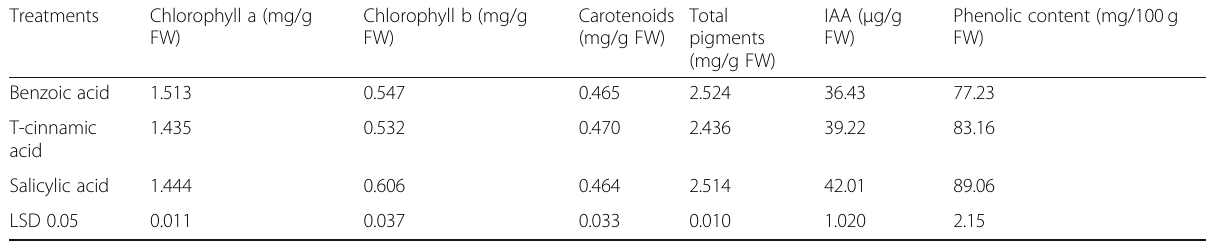
Table 6 Effect of phenolic acid treatments on photosynthetic pigments, IAA and phenolic contents of flax plants grown under sandy soil conditions (Data are means of two successive seasons)